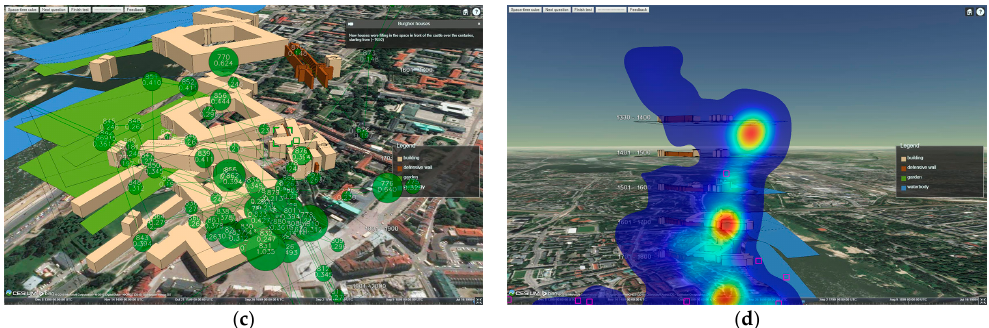
Figure 13. Searching strategies for Q1: ( a ) overview and temporal filter in the slider-based visualization; ( b ) overview and temporal filter in the space–time cube; ( c ) zoom and relate operations in the space–time cube; ( d ) overview and relate operations in the space–time cube.